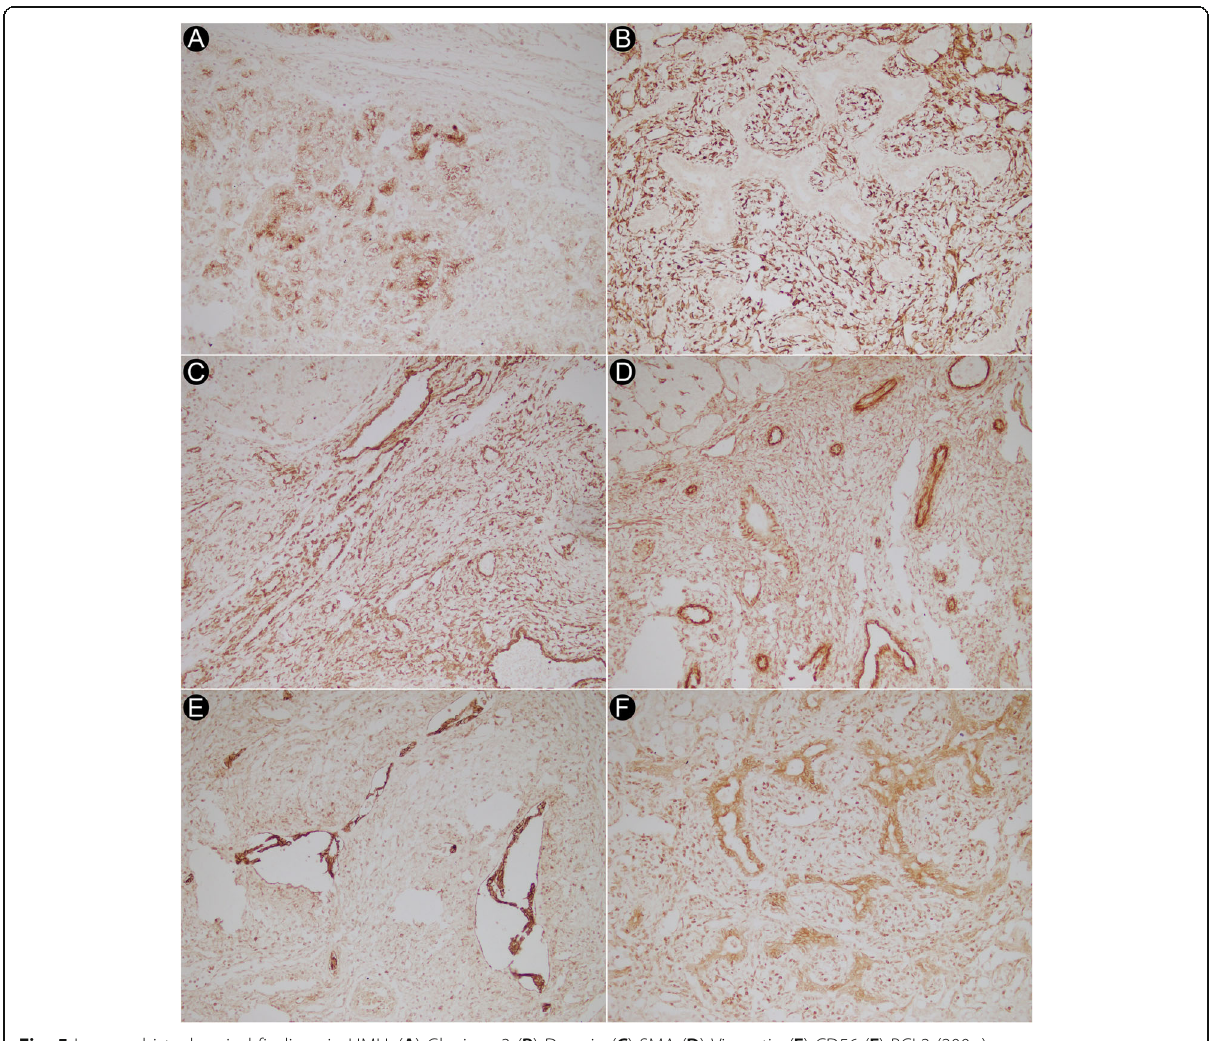
Fig. 5 Immunohistochemical findings in HMH. ( A ) Glypican 3 ( B ) Desmin ( C ) SMA ( D ) Vimentin ( E ) CD56 ( F ) BCL2